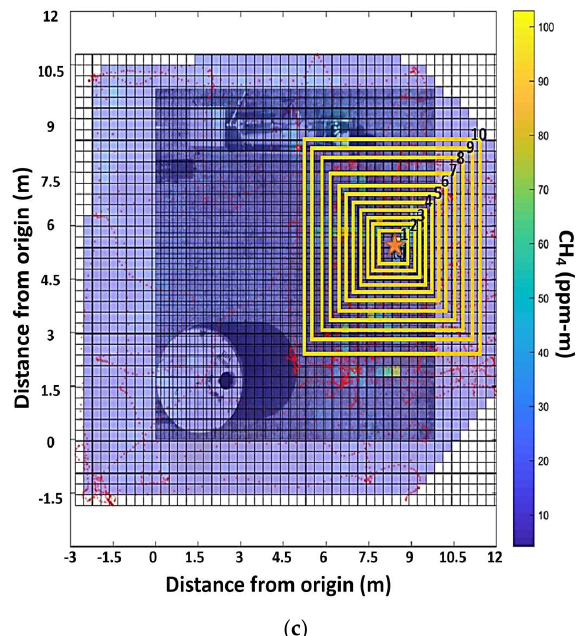
Figure 8. An example of the field test in the well pad site: ( a ) The overlay picture shows the structure of the 10 m × 10 m field site and raster scan trajectories (red line) with several waypoints (indicated by the numbers in the small boxes) covering a field test area. ( b ) Interpolated map of path-integrated CH 4 mixing ratios; the color legend depicts the magnitude of the measurements. ( c ) The schematic of the quantification algorithm implemented by encompassing concentric boxes around the maximum path-integrated CH 4 mixing ratios pixel to get the averaged leak rate estimation. The boxes’ numbers are labeled.